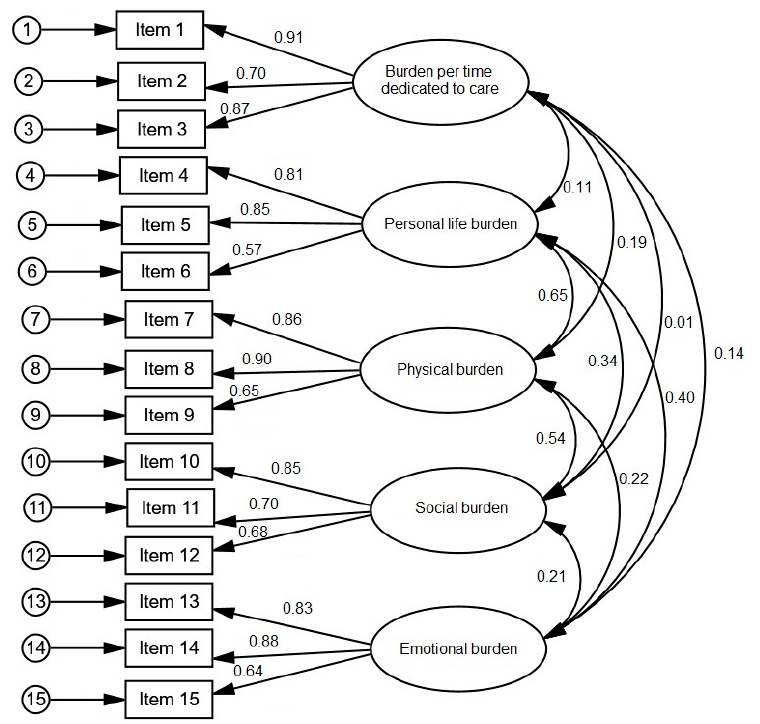
Figure 3. Results of the confirmatory factorial analysis for the 15-item CBI.